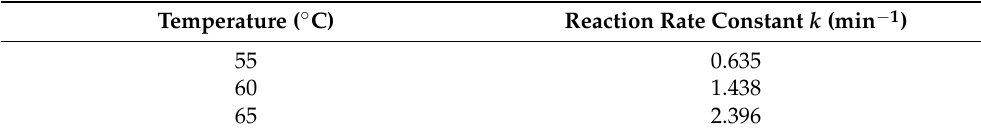
Figure 6. Variations in waste cooking oil concentrations against time at three temperatures. Reaction conditions: a 0.8 wt % NaOH, a microwave power of 600 W, and a 12:1 molar ratio. Table 1. Experimental reaction rate constant ( k ) of the transesterification reaction at different reaction temperatures. Reaction conditions: a methanol-to-oil molar ratio of 12:1, NaOH at 0.8 wt %, a microwave power of 600 W, and a reaction time of 2